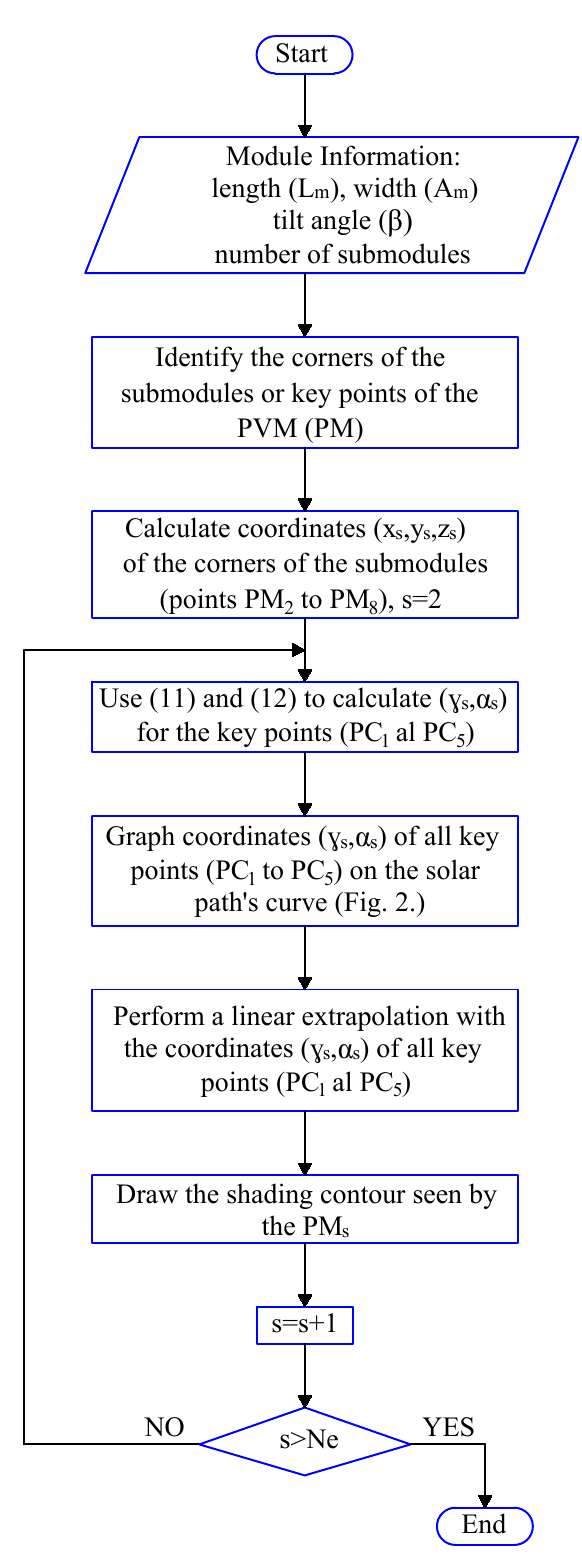
Figure 5. Flowchart for extrapolation of shading